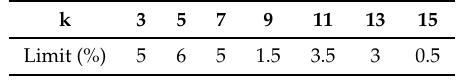
Table 2. The number of phase angles, i.e., M p in Equation (12), selected was 24. Therefore, the total number of tests for each of the two different operating points was equal to 169 ( N 1 = 0, N 2 = 1, K = 15, and N 3 = 24 in Equation (18)). Table 2. Harmonic voltage limits based on standard EN